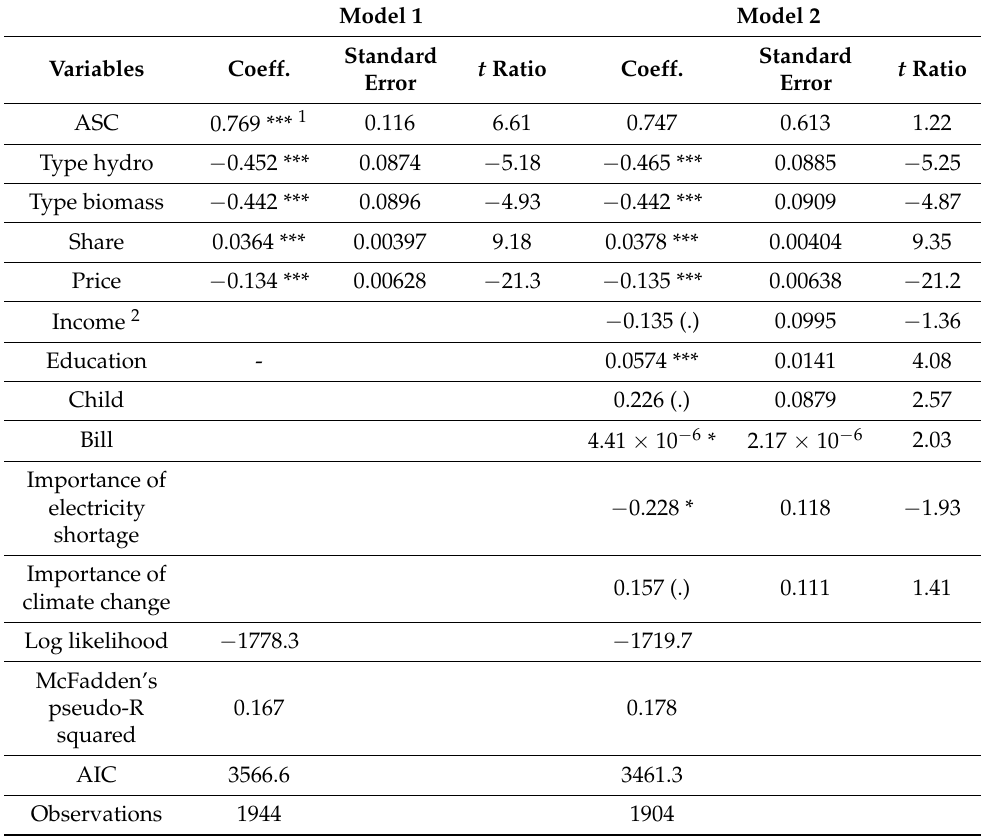
Table 4. Estimation